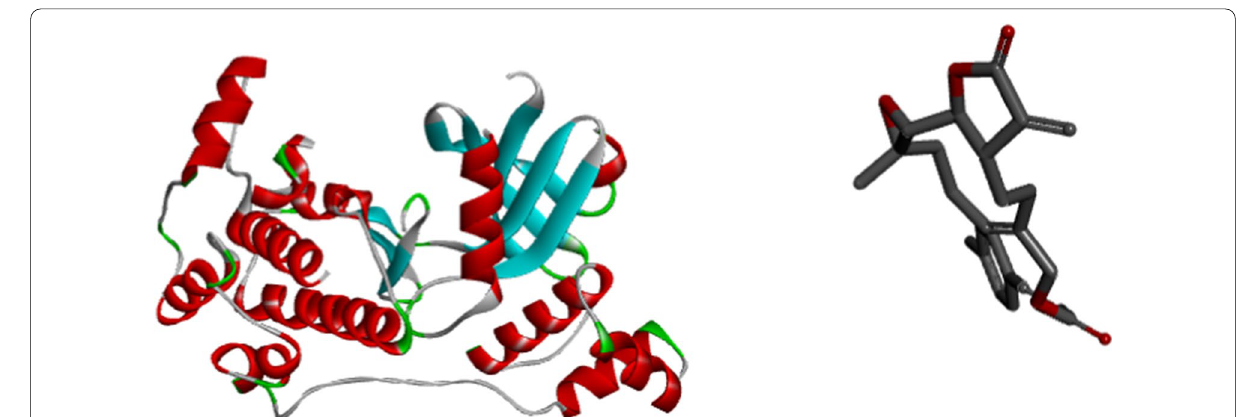
receptor. The derivative also formed hydrophobic bonds (3.72576, 3.10836, 4.3497, 5.0501, 4.61294, 4.86094, 4.17368, 4.84776, 5.45664 and 4.54951 A 0 ) with amino acids of PHE22, ALA23, ALA38, ILE17, VAL25, LEU139, VAL25, ALA38, LEU86 and ILE149 of the protein target. The carbonyl of the compound attached to 3-methylen- edihydrofuran-2(3H)-one acts as a hydrogen acceptor to form one hydrogen bond with